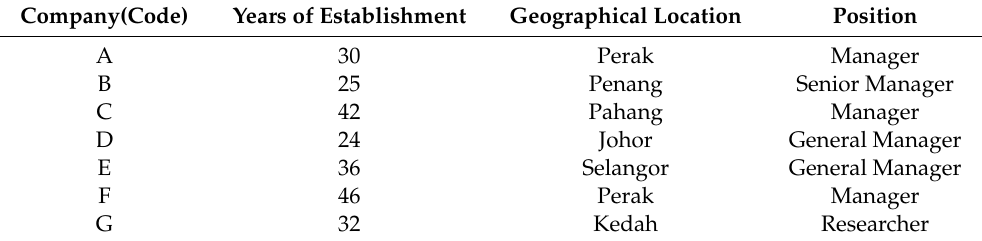
Table 4. Respondent’s